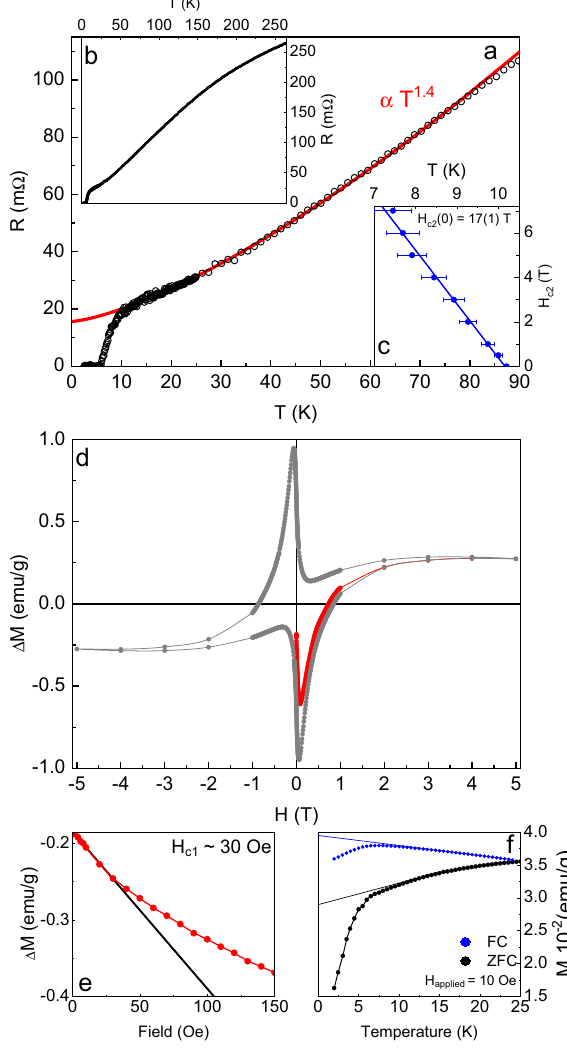
Fig. 3 Electrical and magnetic properties. a Electrical resistance of LaFeSiO 1 − δ as a function of temperature showing superconductivity with onset T c = 10 K and non-Fermi liquid T 1.4 behavior in the normal state. b Extended plot of the resistance up to room temperature. c Superconducting transition temperature versus applied fi eld. The fi t to the WHH formula gives H c 2 (0) = 17 T. Errors are estimated based on the width of the transition. d Superconducting hysteresis loop obtained by difference from the magnetization measured at 2 K and 15 K for a cold-pressed cylinder of polycrystalline LaFeSiO 1 − δ . e A zoom of the initial part of ( d ), fi tted with a linear expression to obtain the susceptibility. f The fi eld-cooled/zero- fi eld-cooled magnetization curves measured on the same pellet of LaFeSiO 1 − δ